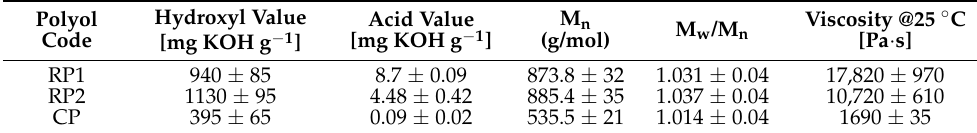
Table 3. Characteristics of the commercial and the recycled polyols.